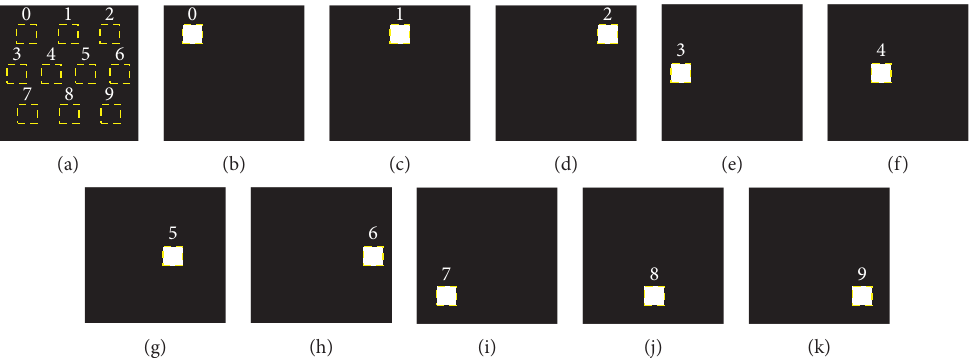
Figure 2: Image label design. (a) Detection area. (b) Label 0. (c) Label 1. (d) Label 2. (e) Label 3. (f) Label 4. (g) Label 5. (h) Label 6. (i) Label 7. (j) Label 8. (k) Label